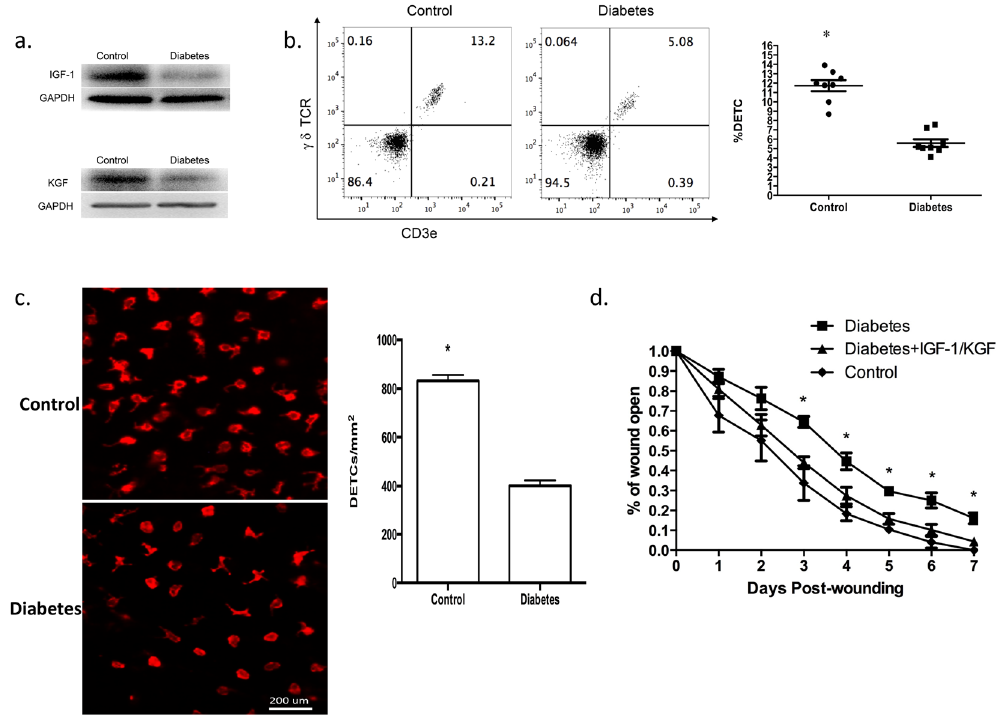
Figure 1. The reduced numbers of DETCs in diabetic mice may affect wound healing by reducing IGF-1/ KGF-1 production. ( a ) 6–8 weeks wild-type male C57BL/6J mice were administered STZ to induce diabetes or vehicle control daily for 6 days. The mice were administered full-thickness wounds in their back skin 4 weeks later. At day 1 after wounding, epidermal sheets around wounds in STZ-induced diabetic or control mice were excised to assess IGF-1 and KGF production by Western analysis. ( b ) Single cell suspensions of epidermal sheets around wounds were stained with γ δ TCR and CD3e antibodies and analyzed by FACS. ( c ) TCR γδ immunofluorescence staining of epidermal sheets from STZ-induced diabetic or control mice, the number of γ δ T cells was quantified per mm 2 . ( d ) Application of IGF-1 and KGF to the wounds promoted wound healing in STZ-induced diabetic mice. All data represent at least three independent experiments and each experiment includes 2 animals (one control and one experimental mouse). All error bars represent mean ± SEM. * P <